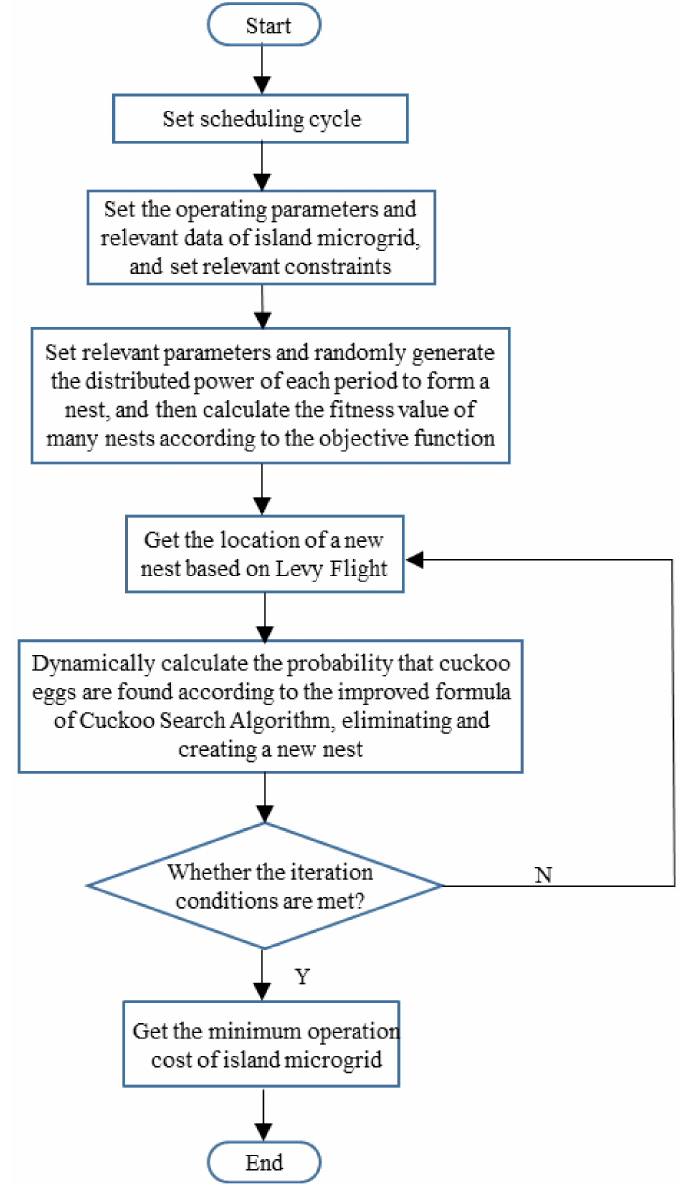
Figure 5. Flow chart of improved CS